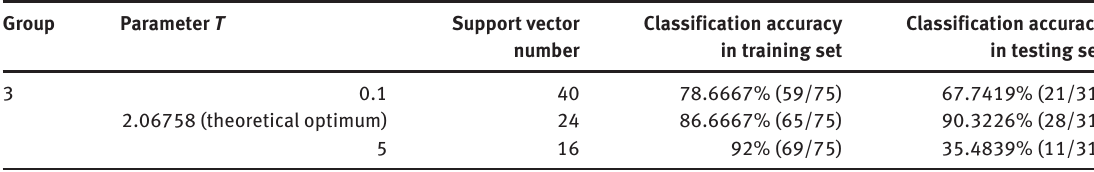
Table 6: The Classification Accuracy in the Third Group of Experimental Model.